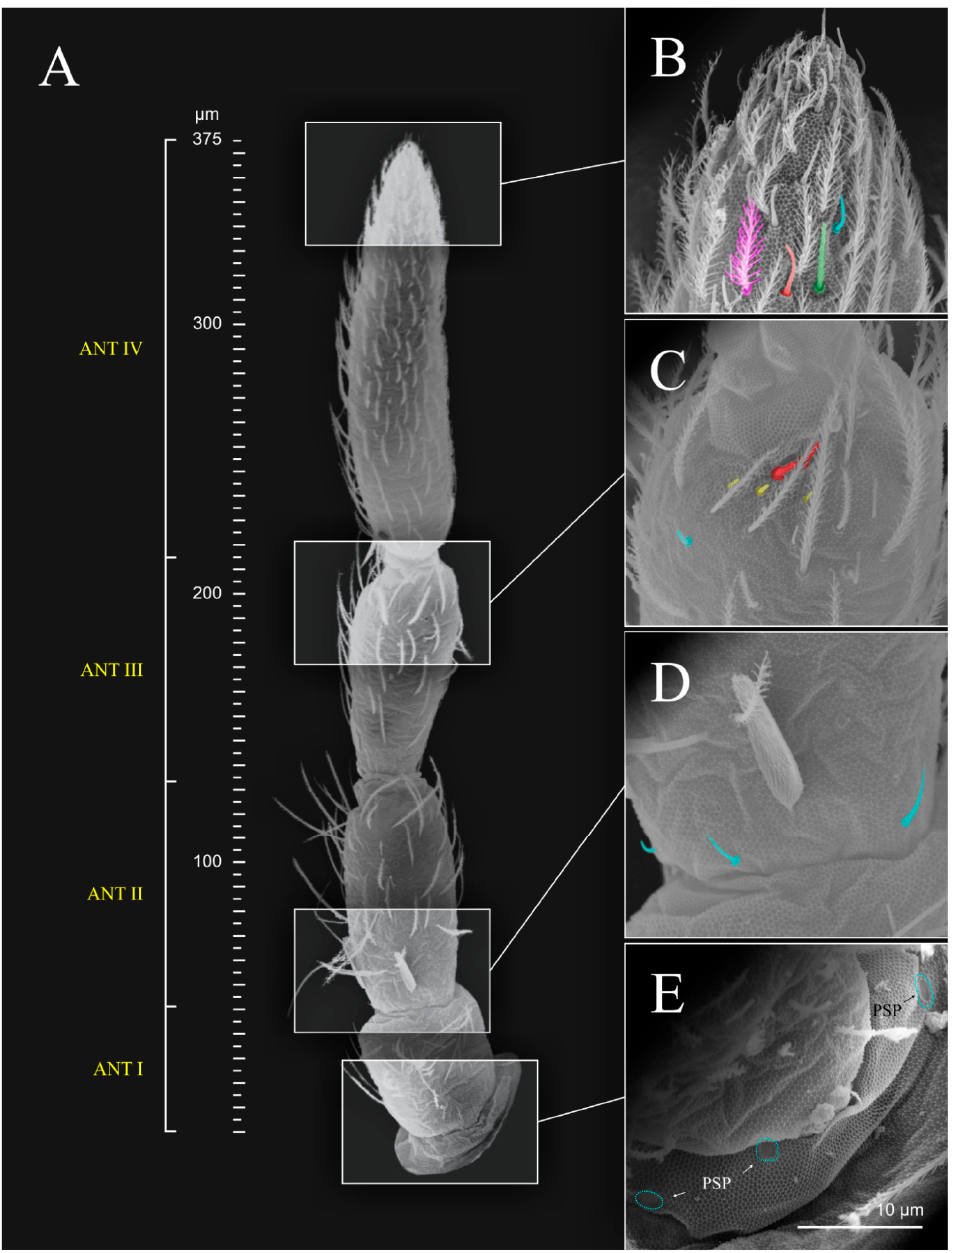
Figure 7. Seira musarum SEM . ( A ), antenna (right side) lateral view; ( B ), antennal segment IV apex, with the different types of chaetae shown in color; ( C ), antennal segment III apex, detail of the apical organ; ( D ), antennal segment II base with colored details for the microchaetae; ( E ), antennal segment I base, with dashed lines in the pseudopores.